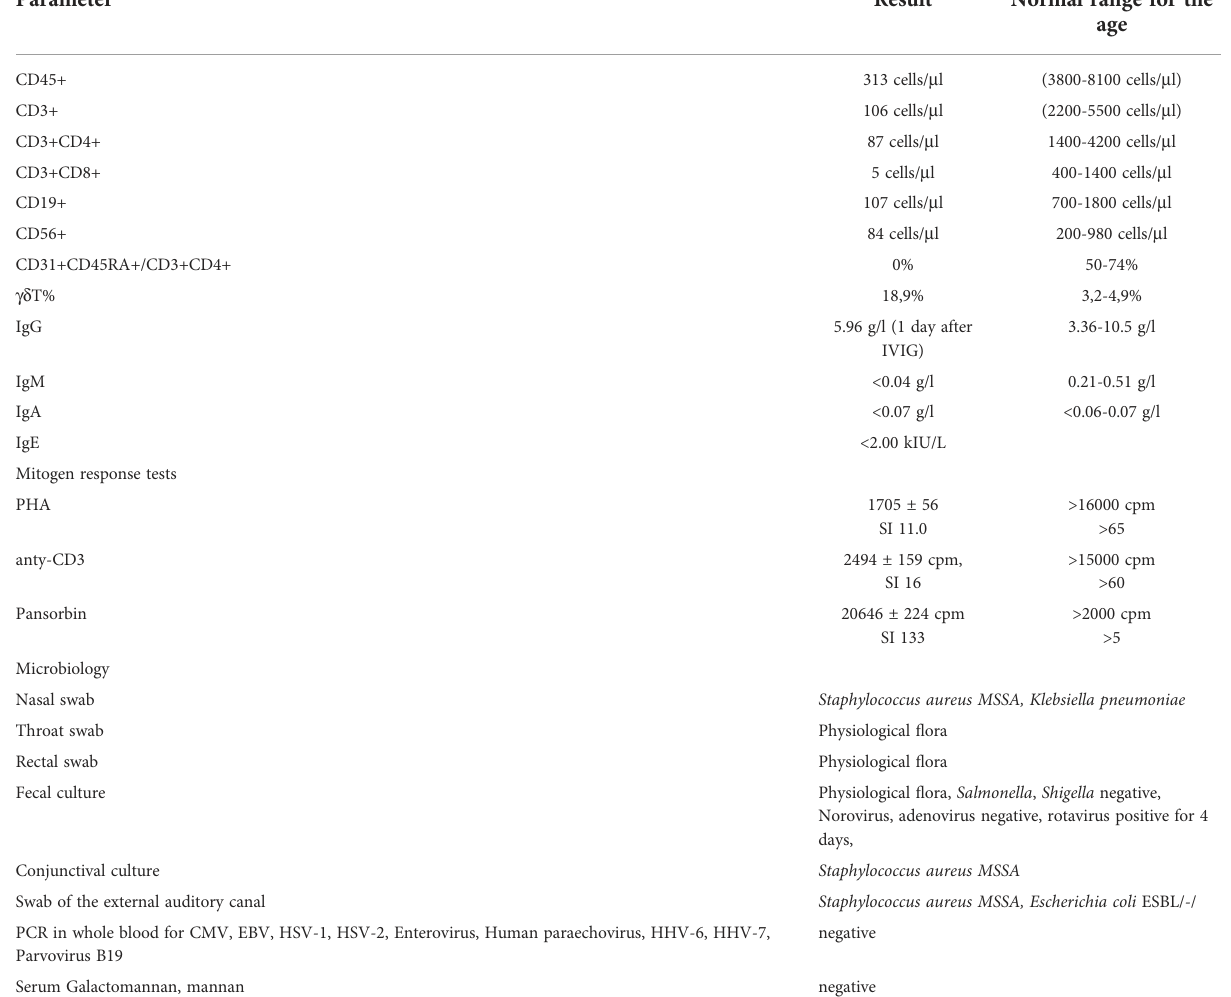
TABLE 1 Laboratory results at the time of